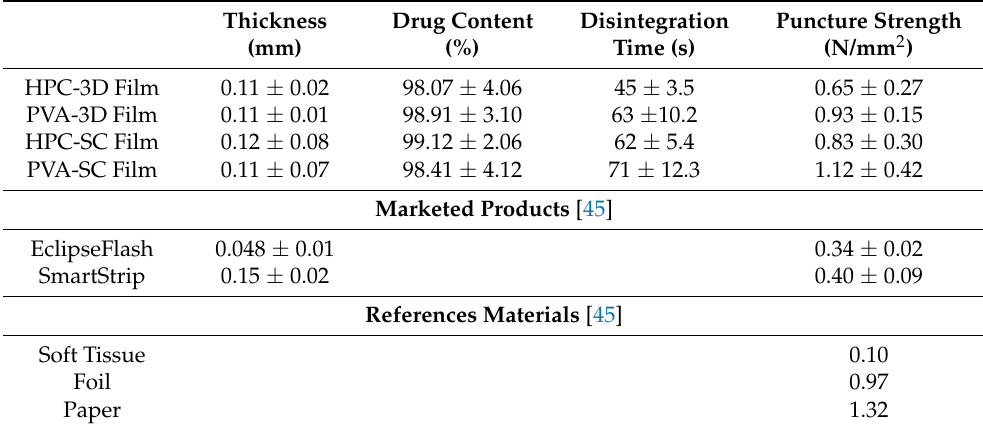
Table 2. Investigation of mechanical properties of marked products, materials, and developed orodispersible films.